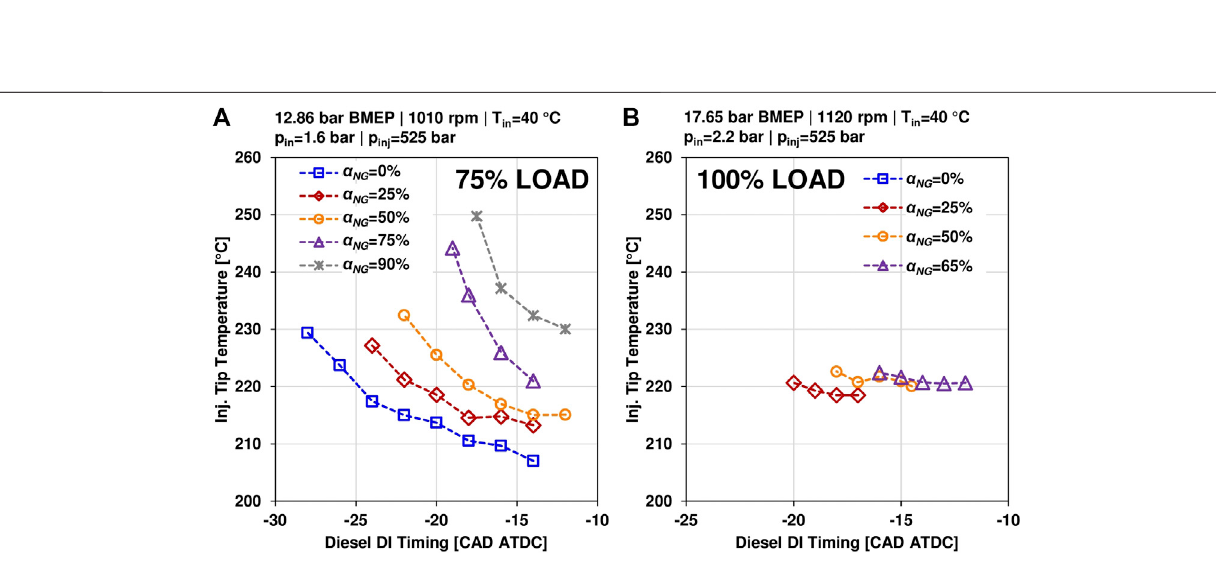
Frontiers in Mechanical Engineering |